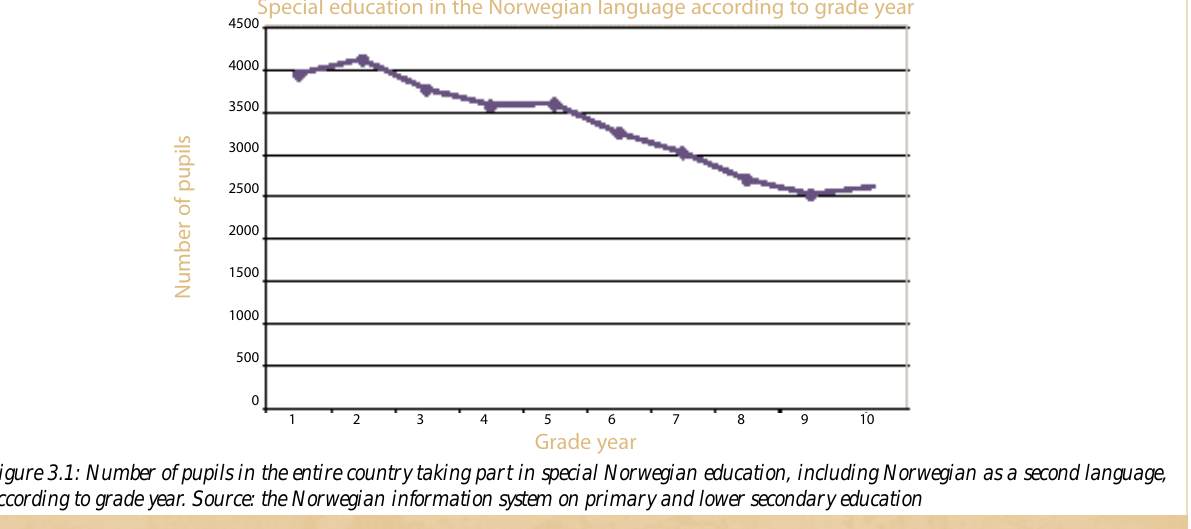
Figure 3.1: Number of pupils in the entire country taking part in special Norwegian education, including Norwegian as a second language, according to grade year. Source: the Norwegian information system on primary and lower secondary